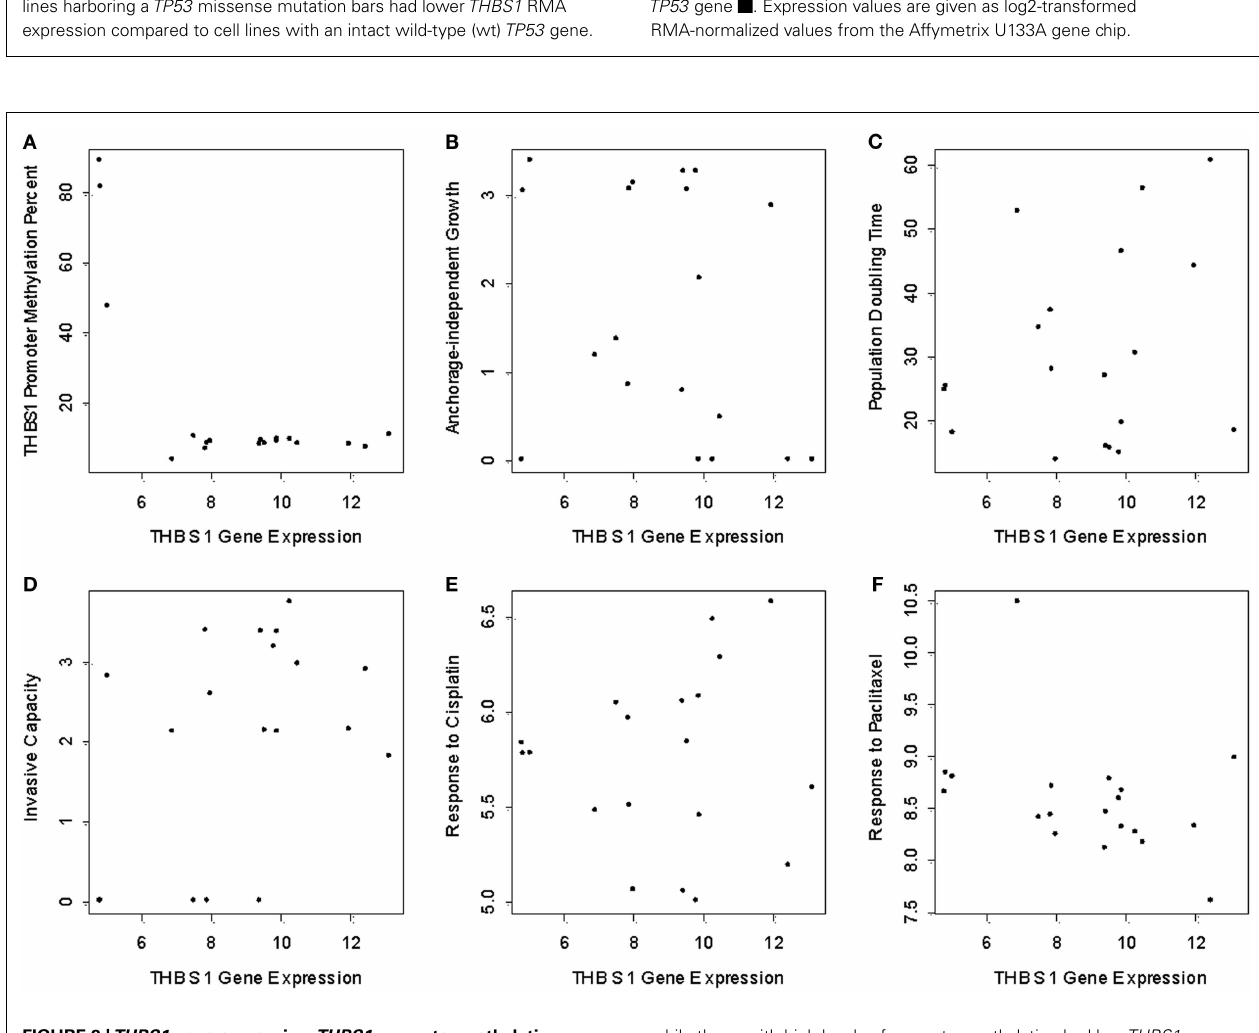
FIGURE 2 | THBS1 gene expression, THBS1 promoter methylation, tumor growth properties, and chemotherapy-induced growth inhibition . Pyrosequencing shows low levels of methylation in the cell lines (median = 8.6%; range = 3.5 to 88.8%). (A) Cells with low levels of promoter methylation exhibited higher THBS1 gene expression,